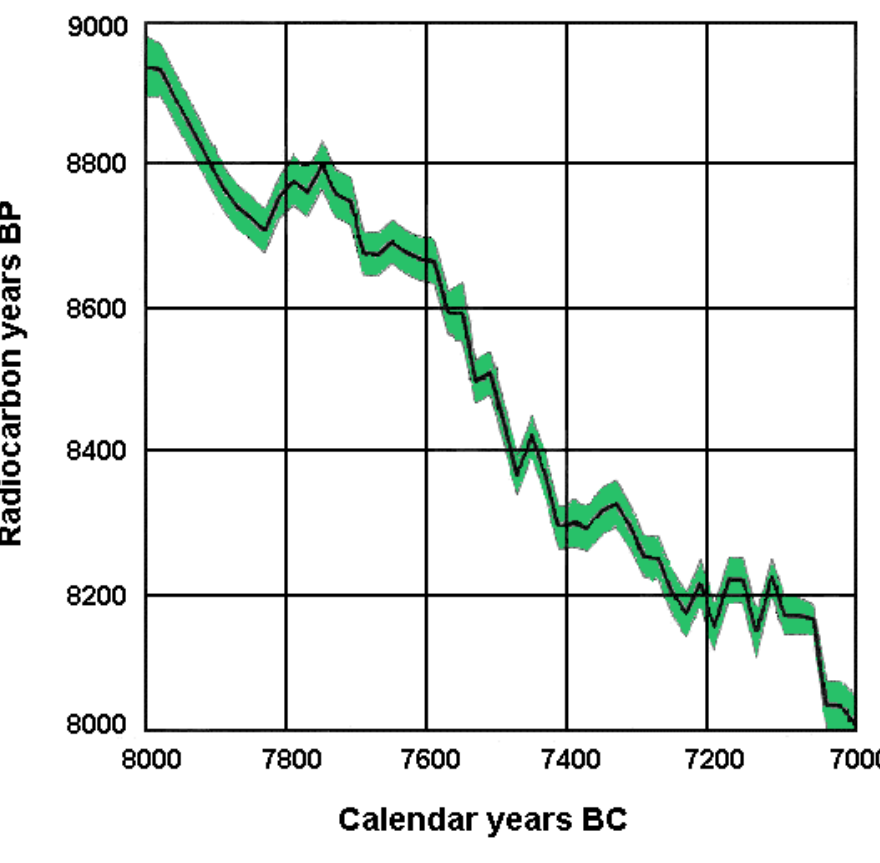
Figure 6: Dates after calibration curve (after Stuiver and Reimer